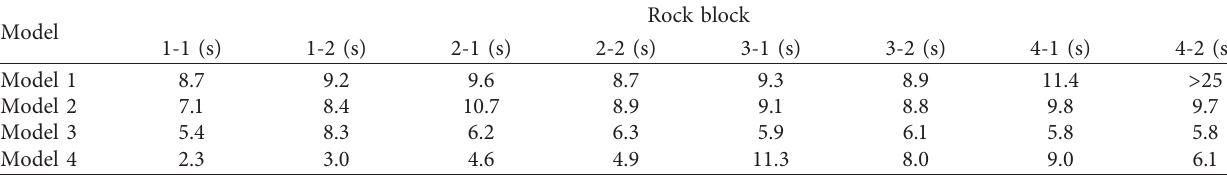
Table 7: Fracture failure timetable of each model rock